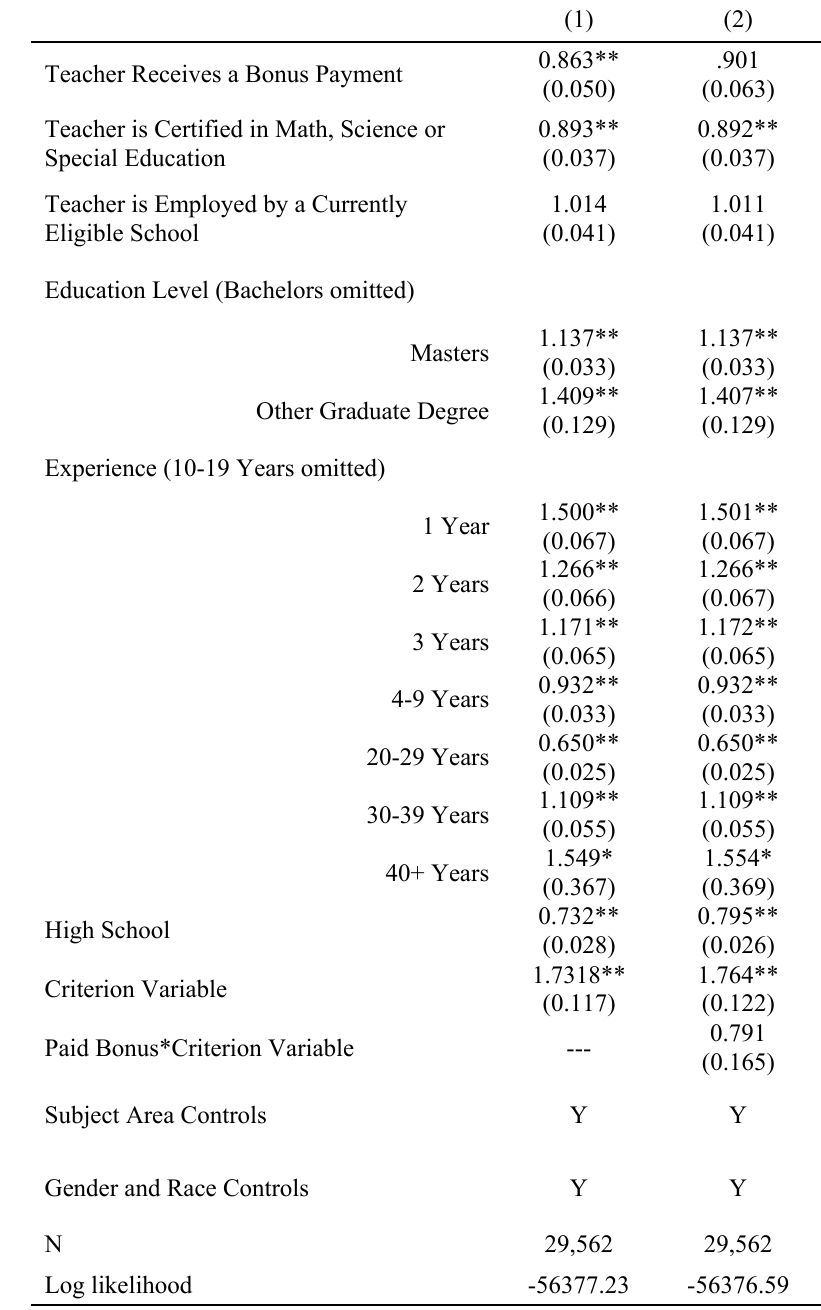
Table 6 : The Role of Information